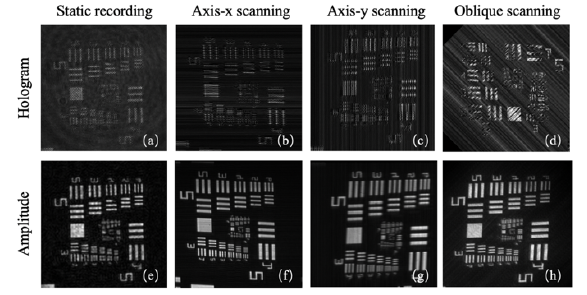
Fig. 1. Preliminary experimental results of self-assembling modality. (a) conventional hologram; (b)-(d) space-time holograms by x, y and oblique scanning; (e)-(h) amplitude reconstruction results.